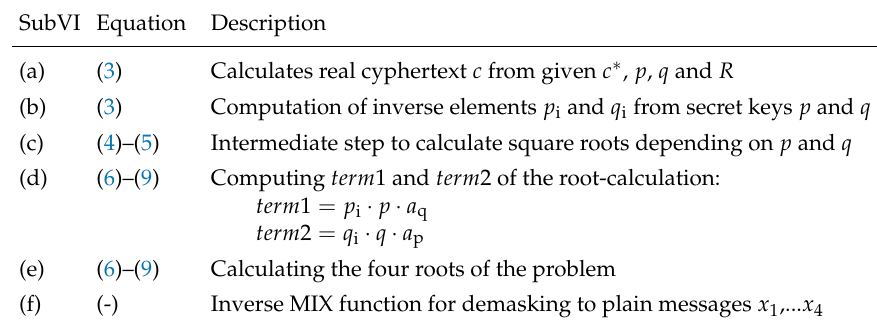
Figure 3. Decryption process implemented in LabVIEW: The crypt c ∗ and both secret keys p and q are inputs. The four possible solutions are computed by the LabVIEW-SubVI Blocks: ( a ) Reduce Montgomery; ( b ) Extended Euclidean Algorithm; ( c ) Get-Root; ( d ) make CRT-Term; ( e ) Calculate Root; ( f ) Inverse MIX-Function. Table 1. Correlation between the LabVIEW SubVI-Blocks and RAMON decryption